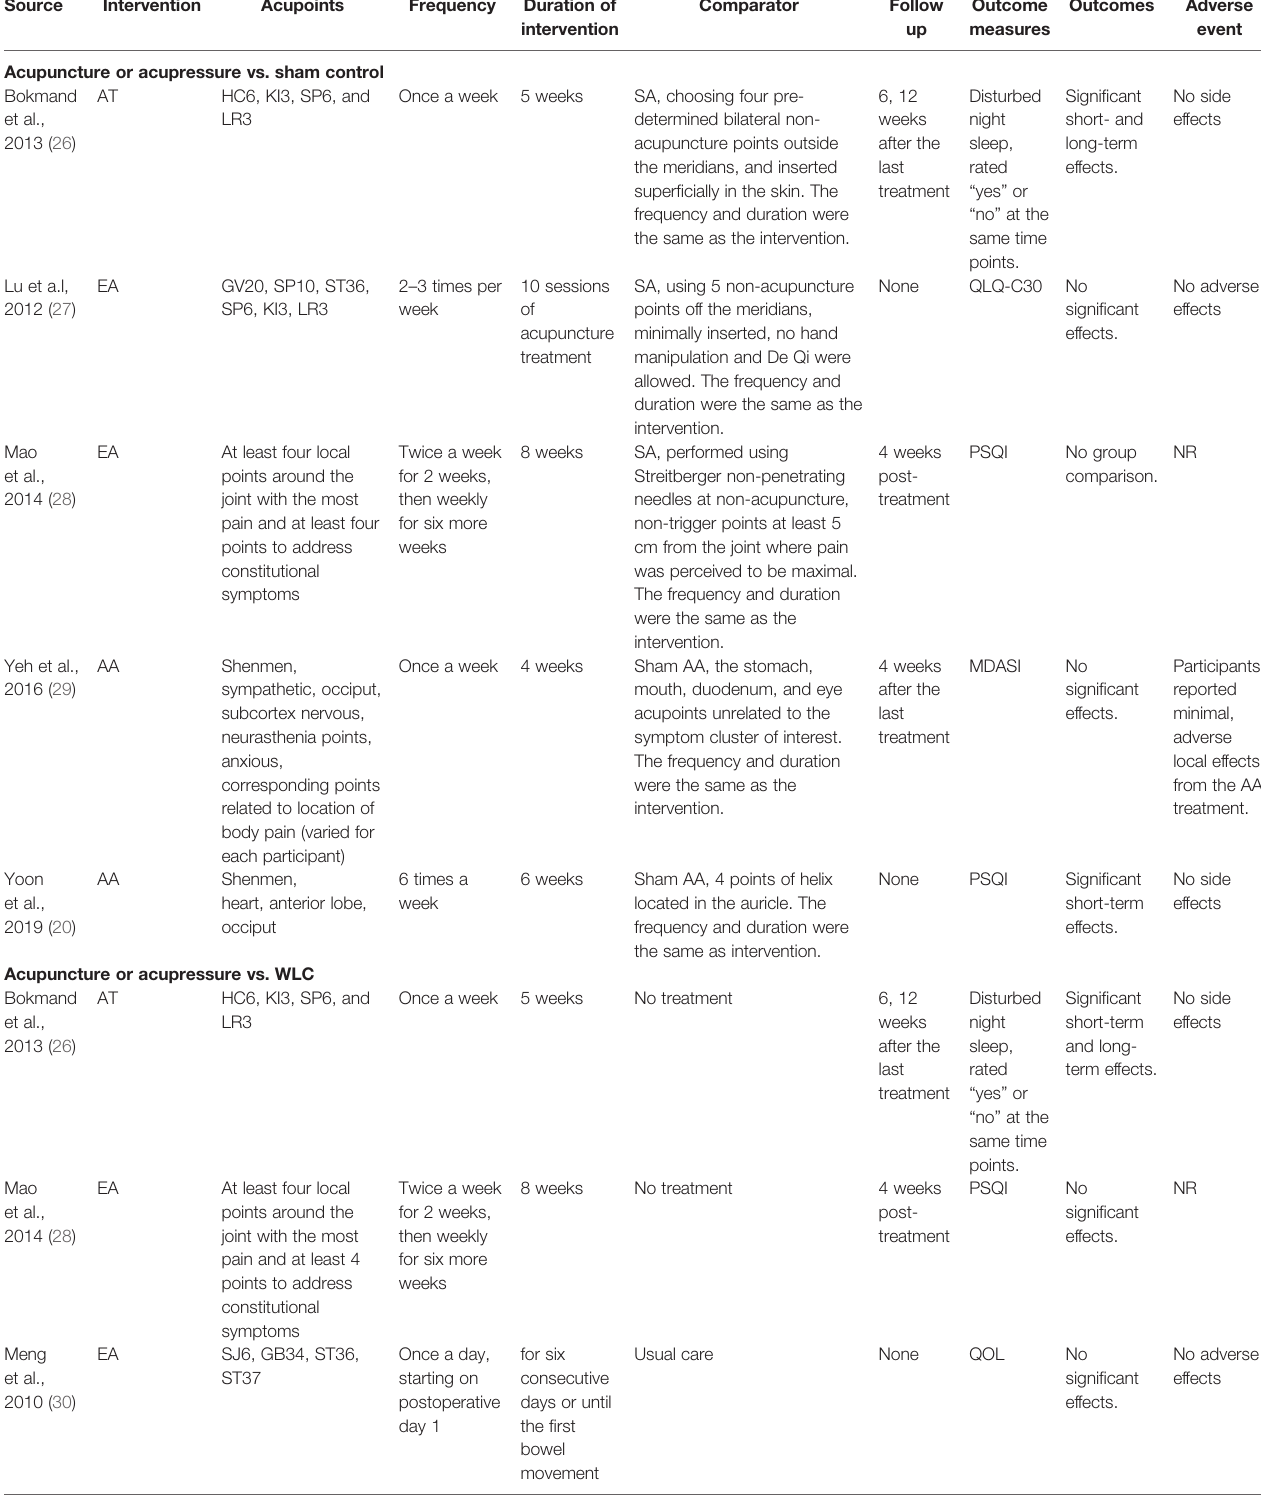
TABLE 3 | Characteristics of interventions, comparators, and